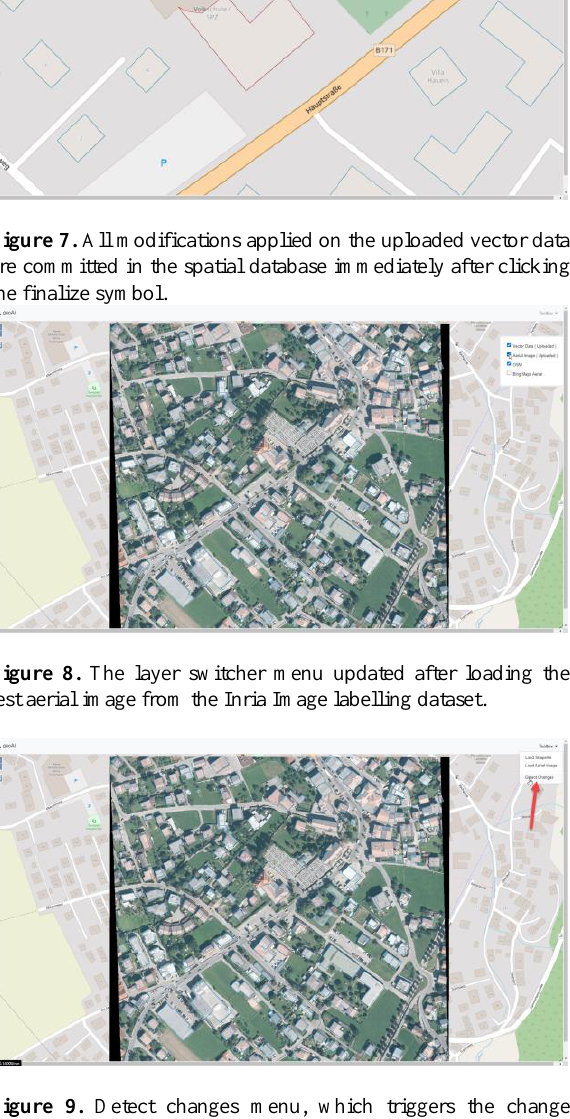
Figure 9. Detect changes menu, which triggers the change detection component by applying the DL